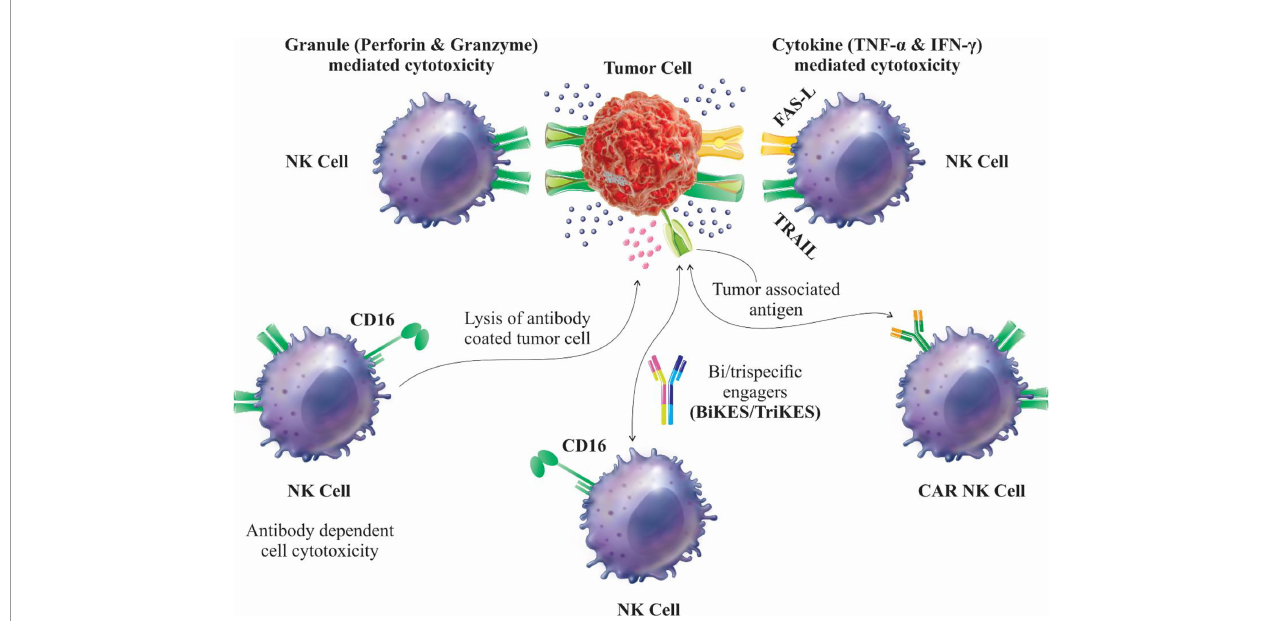
FIGURE 1 | Mechanisms of NK cell cytotoxicity against tumors. The Fc receptor CD16 is presented on NK cells following the identi fi cation of antibody-coated cells stimulates a signal to NK cells, enabling tumor cell eradication by direct lysis and cytokine generation. Despite the secretion of perforin and granzymes for tumor cell killing, NK cells elicit ADCC via the membrane receptor CD16, or apoptotic axis mediated through FASL and TRAIL. Furthermore, BiKEs and TRiKEs that induce NK cells toward one or more TAAs are the capable strategies for treating human solid tumors; on the other hand, CARs re-direct NK cells against tumor cells showing speci fi c antigens, making key opportunities in the battle toward tumors. NKCs, Natural killer cells; BiKEs, Bispeci fi c killer cell engagers; TRiKEs, Trispeci fi c killer cell engagers; TAAs, Tumor-associated antigens; TRAIL, Tumor necrosis factor-related apoptosis-inducing ligand; FasL, Fas ligand; ADCC, Antibody-dependent cellular cytotoxicity; CARs, Chimeric antigen